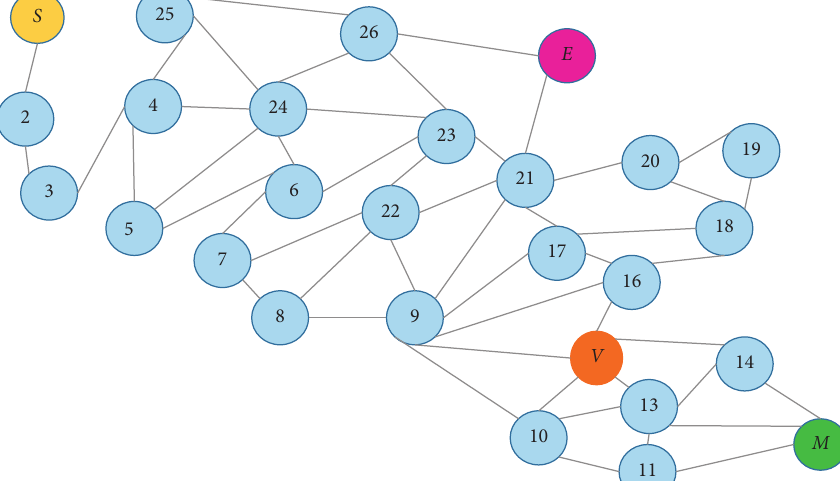
Figure 5: Undirected network graph 1.